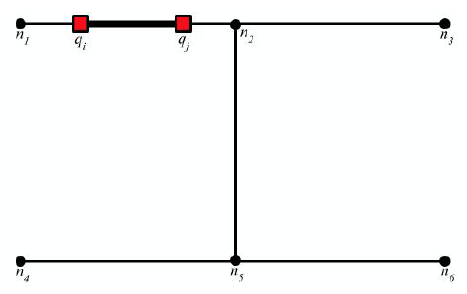
(cid:16) (cid:17) n 2 q j for each query segment q ∈ q i q j .